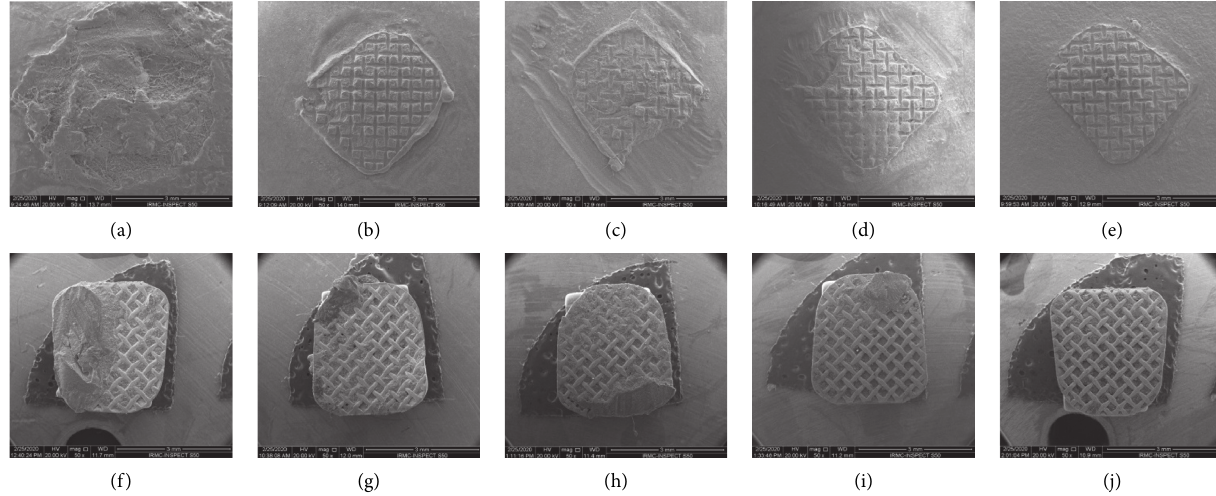
Figure 3: Representative SEM images for deboned surface after the SBS test. (a–e) Crown surfaces; (f–j) bracket surfaces. (a) Control, (b) blue bur, (c) green bur, (d) black bur, and (e) sandblasting